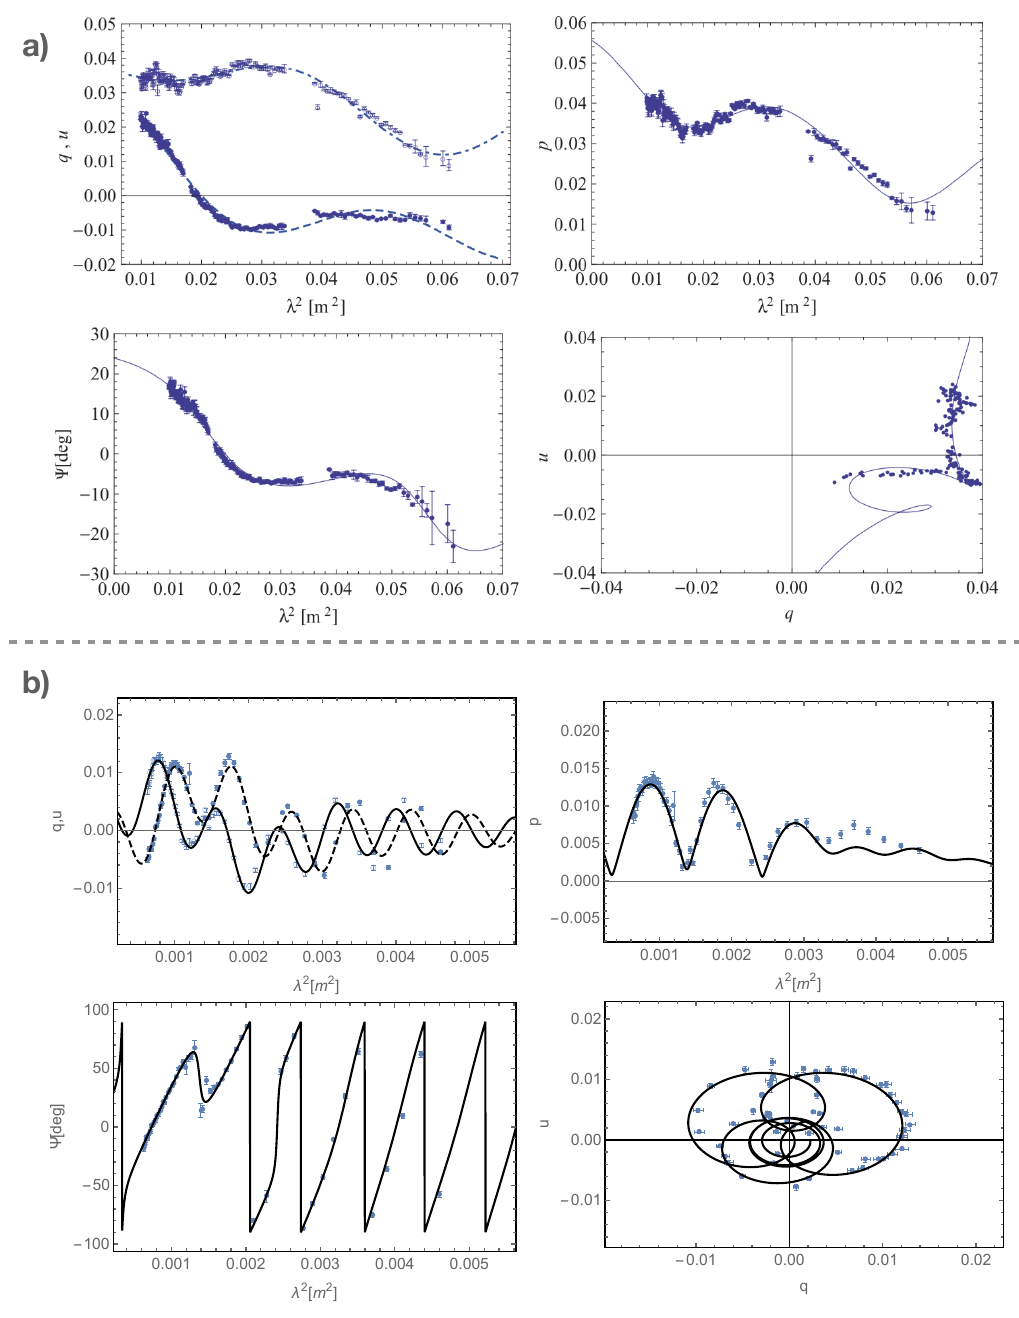
Figure 2. Depolarization Stokes QU-fitting on the sources: ( a ) PKSB1039-47 and ( b ) 0958+3224. The four panels represent: the Stokes parameters q , u ( top left ), the fractional polarization p ( top right ), the polarized angle χ [deg] ( bottom left ) all versus wavelength squared λ 2 [m 2 ] and the Stokes u versus Stokes q ( bottom right ). Straight lines are the resulting model fit. Both sources have been fitted with three internal Faraday screens (Equation (10)). Images adapted from